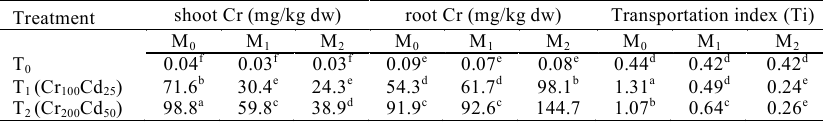
Table 4: Effect of application of heavy metals and type of organic substances in concentration and transportation index of Cr in maize plant (shoot and root) Treatment shoot Cr (mg/kg dw) root Cr (mg/kg